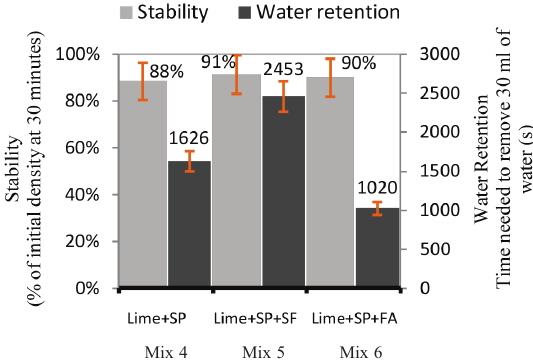
Fig. 3(b). Effect of pozzolans and SP on stability and water retention of different grout mixes